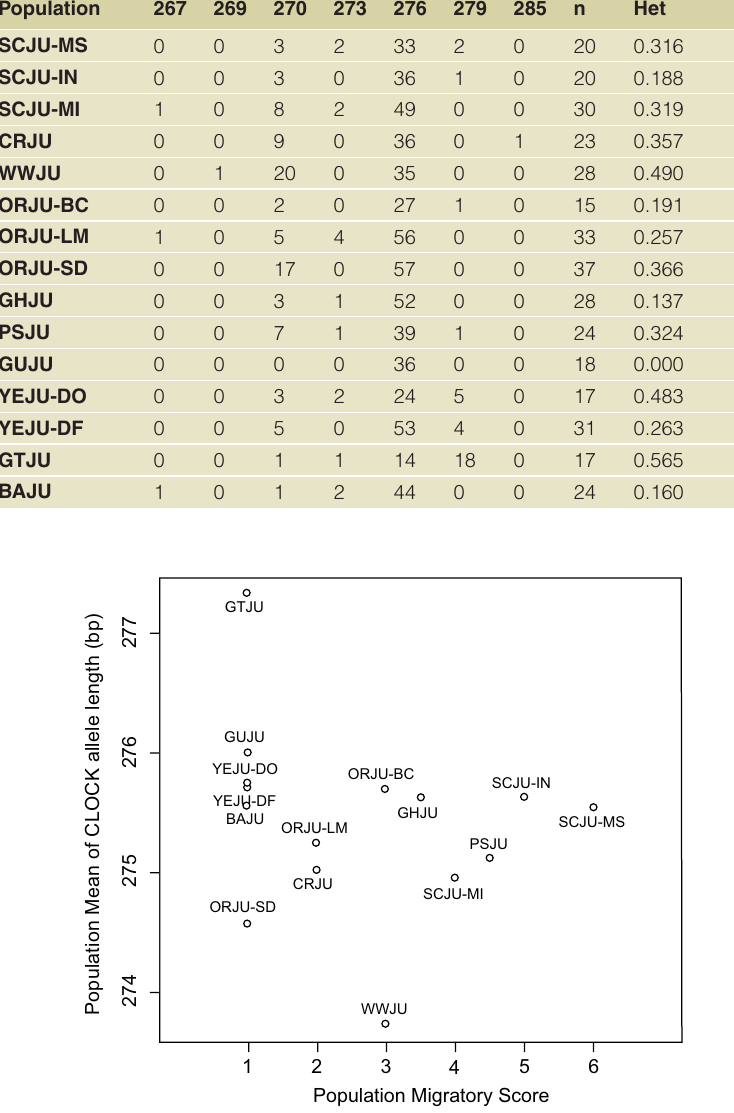
Table 4. Distribution of CLOCK allele length within each population. Table lists the number of individuals, from each population, possessing each of the identified CLOCK alleles. Number of individuals genotyped is indicated as “n” for each population. Het = calculated heterozygosity for the population. Other abbreviations follow from Table 1.